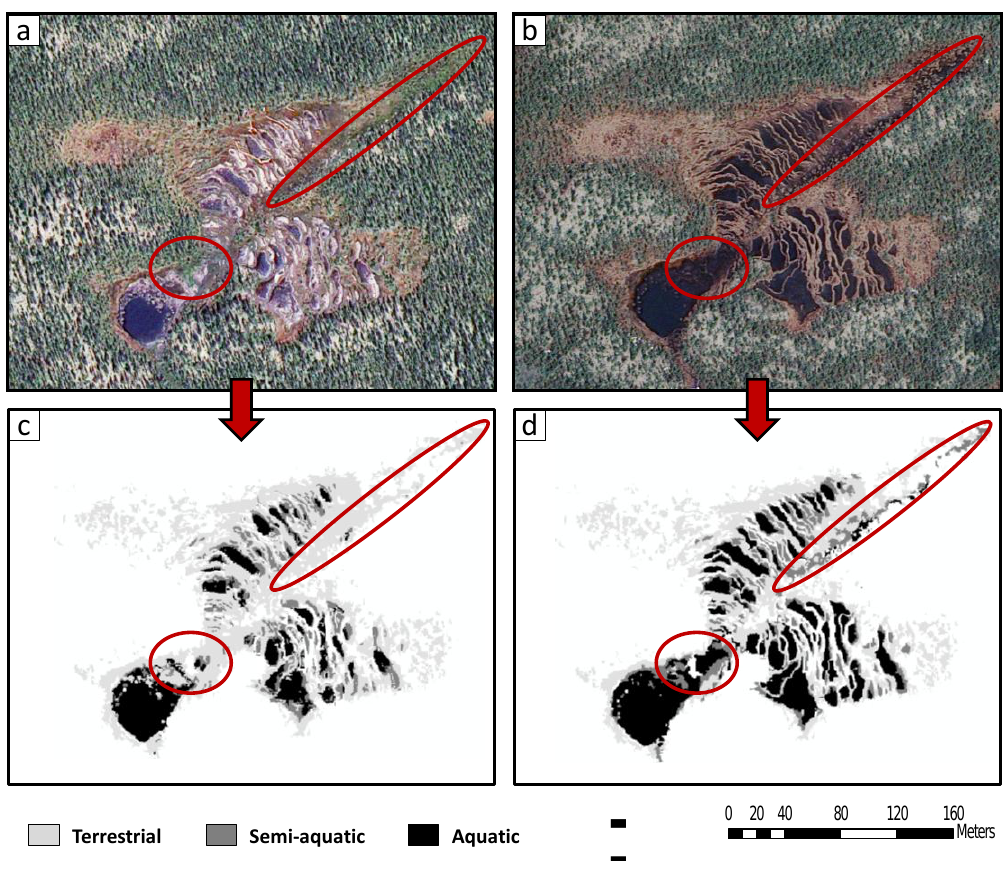
Figure 8. Comparison between ( a ) 23 July 2009 and ( b ) 18 May 2010 GeoEye-1 RGB images (subsets centered on site 1: 54°06′52″N, 72°30′02″W), and the respective aquatic, semi-aquatic, and terrestrial proportions of the site 1 saturated zone ( c , d ). Areas of major change are encircled in